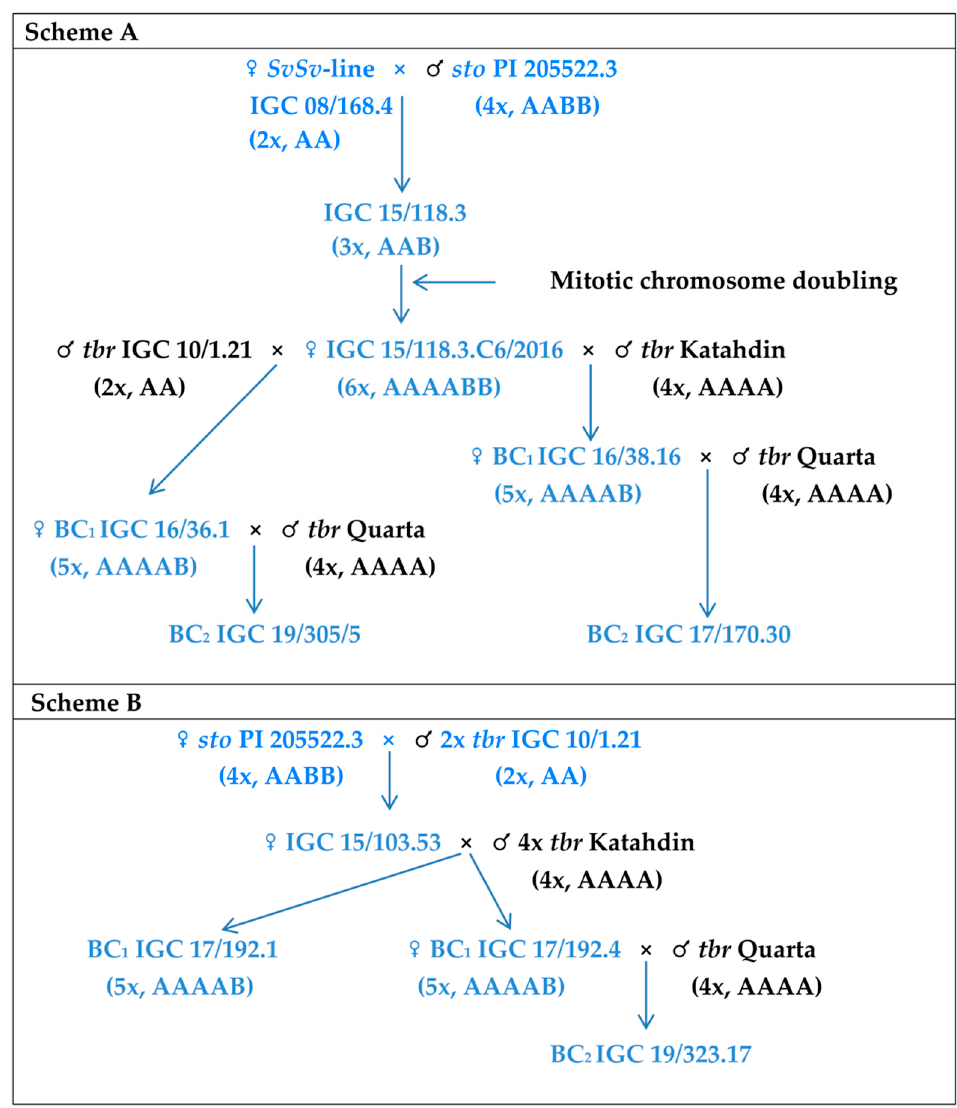
Figure 1. Crosses used for development of the introgressive forms which were analyzed in the present study. Expected genome composition is indicated in brackets. All pollinators are marked by black color, and maternal hybrid forms by blue color.